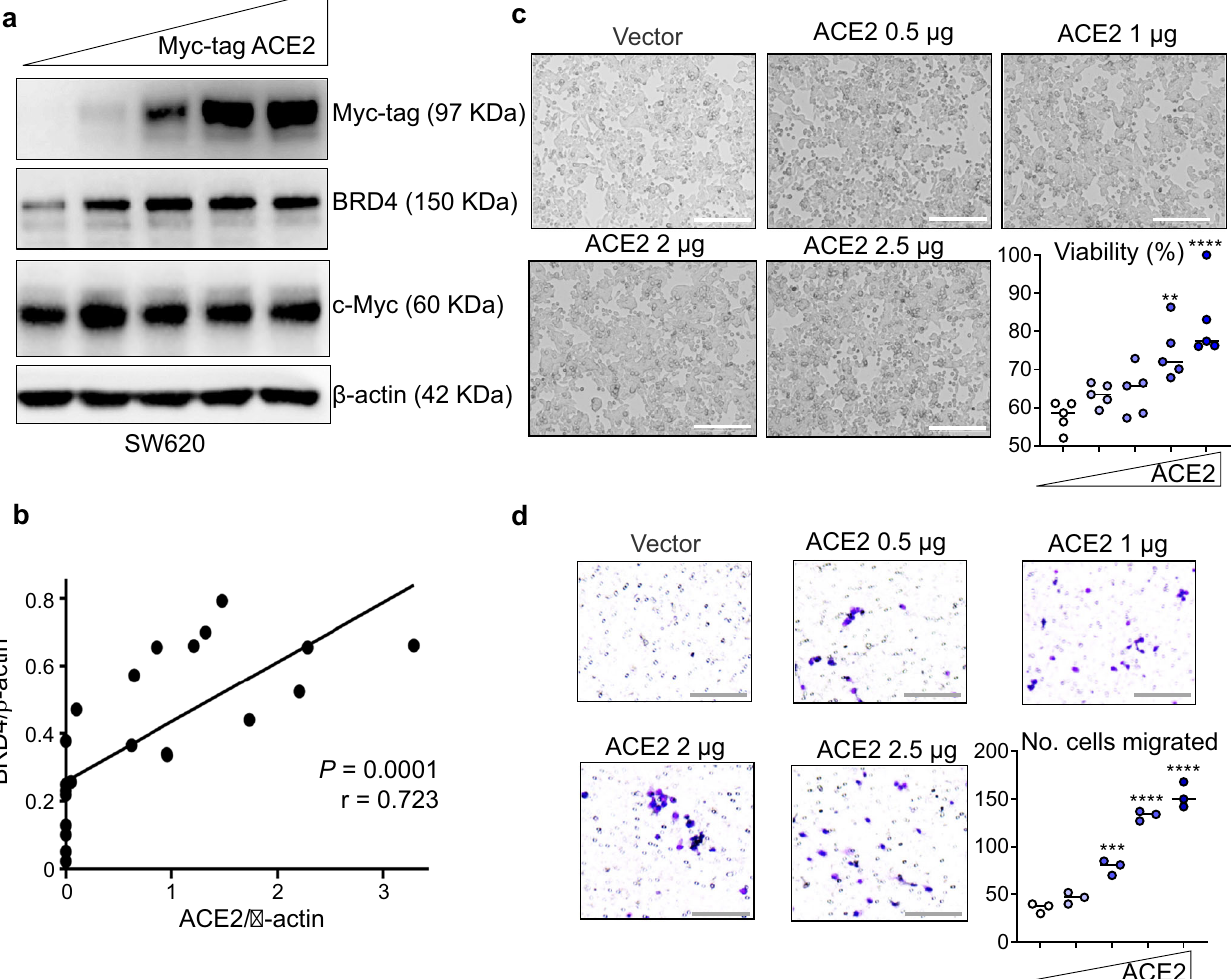
Fig. 3 Forced expression of ACE2 increases endogenous BRD4 and enhances the viability and migration of colon cancer cells. a Immunoblotting 48 h after transient transfection of 0 (vector alone), 0.5, 1, 2, or 2.5 μg Myc-tagged ACE2 in SW620 cells. b Densitometric analyses in SW620 cells of BRD4 vs. ACE2, normalized to β -actin, after replicate experiments (as in a ). c Representative images and cell viability data in the CCK8 assay; scale bars = 200 μ m. d Representative images and quanti fi cation of SW620 cell migration after crystal violet-staining (scale bars = 200 μ m). In c , d , difference between means from n = 5 or n = 3 replicates, as indicated, 48 h after transient transfection of Myc- tagged ACE2, as in a (wedge symbol); ** p < 0.01, *** p < 0.001, **** p < 0.0001 by Student ’ s t test vs. 0-μg vector control. GraphPad Prism dependently reversed the PARP cleavage associated with loss of BRD4 upon dBET6 treatment (Fig. 4e). Additional rescue experi- ments were not conducted on cell migration and viability phenotypes, which represents a limitation of the current study worthy of further investigation. Finally, we reported previously on the tumor growth inhibition and loss of BRD4 protein expression in SW620 cells grown as xenografts in nude mice treated with dBET6, alone or in combination with a histone deacetylase revealed marked depletion of ACE2 in mice treated with dBET6 in vivo (Fig. 4f, red box). highlight the yin/yang nature of targeting ACE2 in cancer etiology. Knockdown and overexpression experiments in human colon cancer cells implicated an apparent oncogenic role for ACE2, with pharmacologic BET inhibition recapitulating molecular and pheno- typic readouts, including loss of c-Myc, cell growth inhibition, and apoptosis induction. Future work should clarify the precise mechanisms of ACE2-BRD4 crosstalk, acting at the level of transcriptional regulation, post-translational modi fi cations and/or